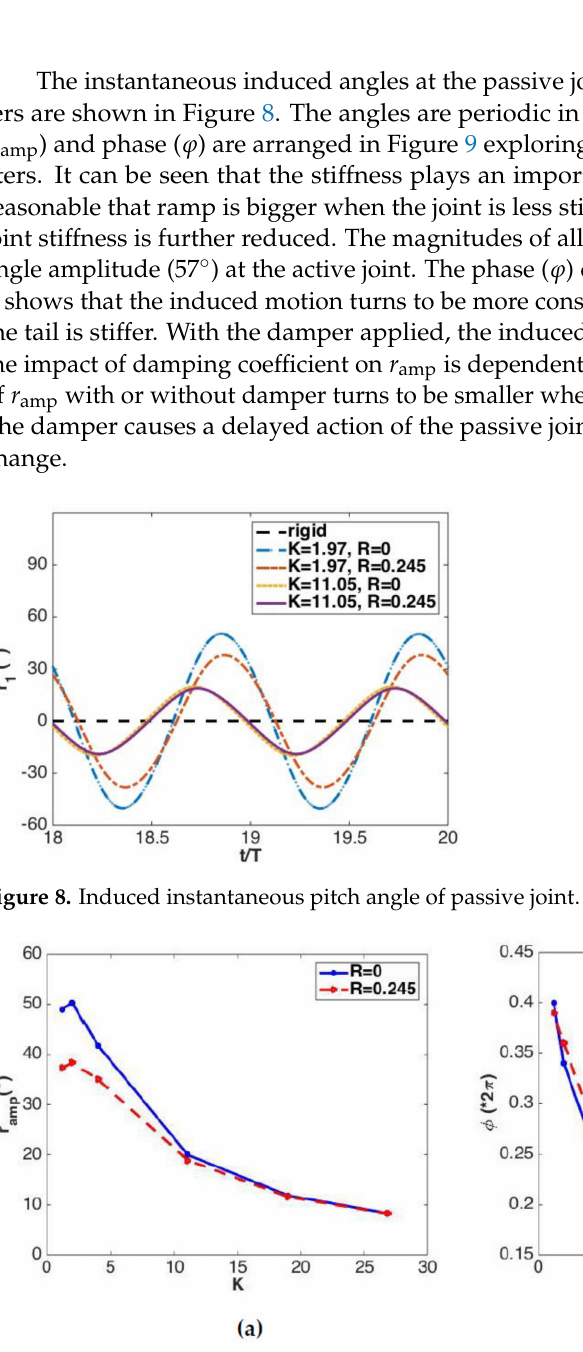
Figure 9. ( a ) Amplitude ( r amp ) and ( b ) phase shift ( ϕ ) of induced pitch